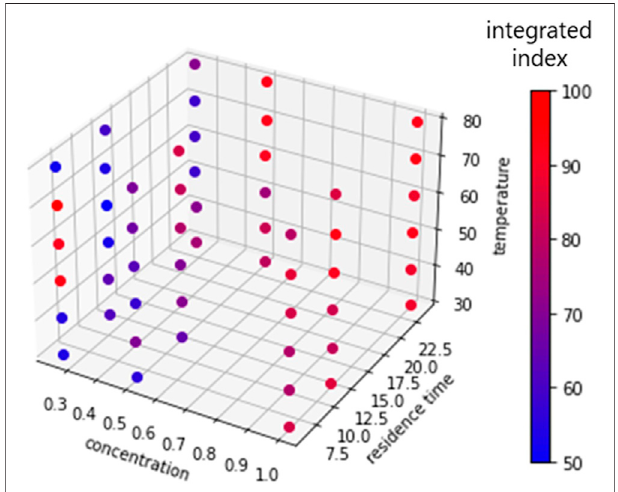
FIGURE 4 | The results of the grid condition search for the semihydrogenation reaction. The integrated indexes are represented on a color scale: blue (cid:1) low yield, red (cid:1) high yield. See Supporting information for